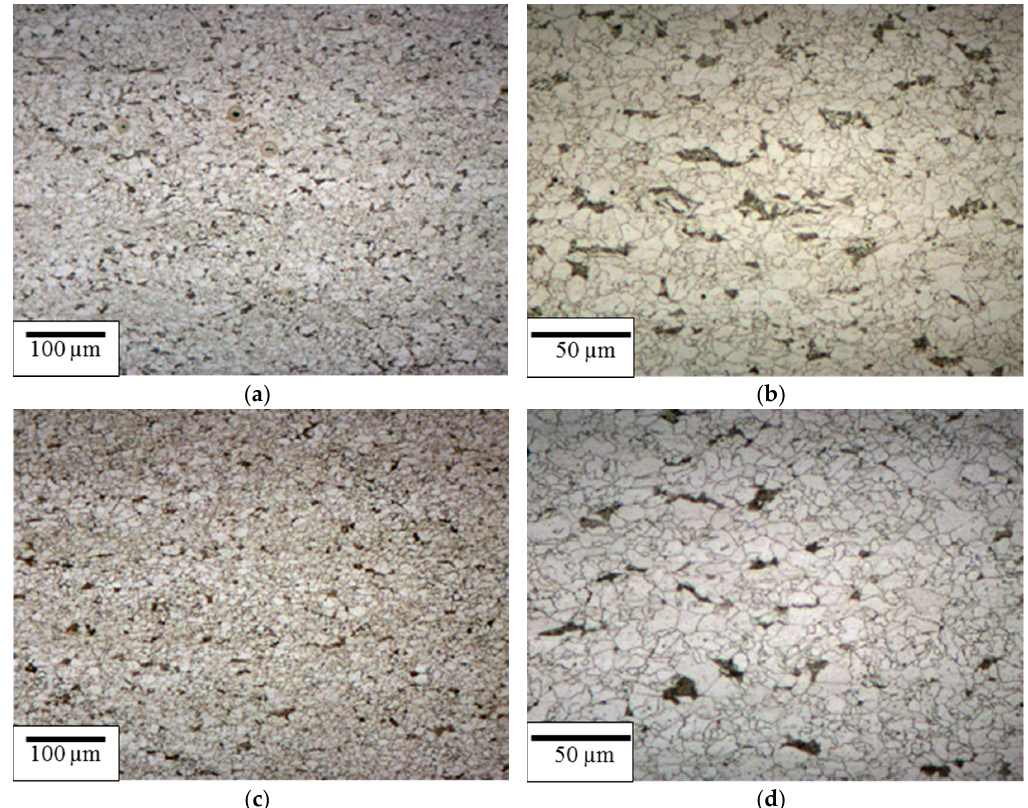
Figure 4. The results show that the microstructures of steel samples from both heats are very similar.